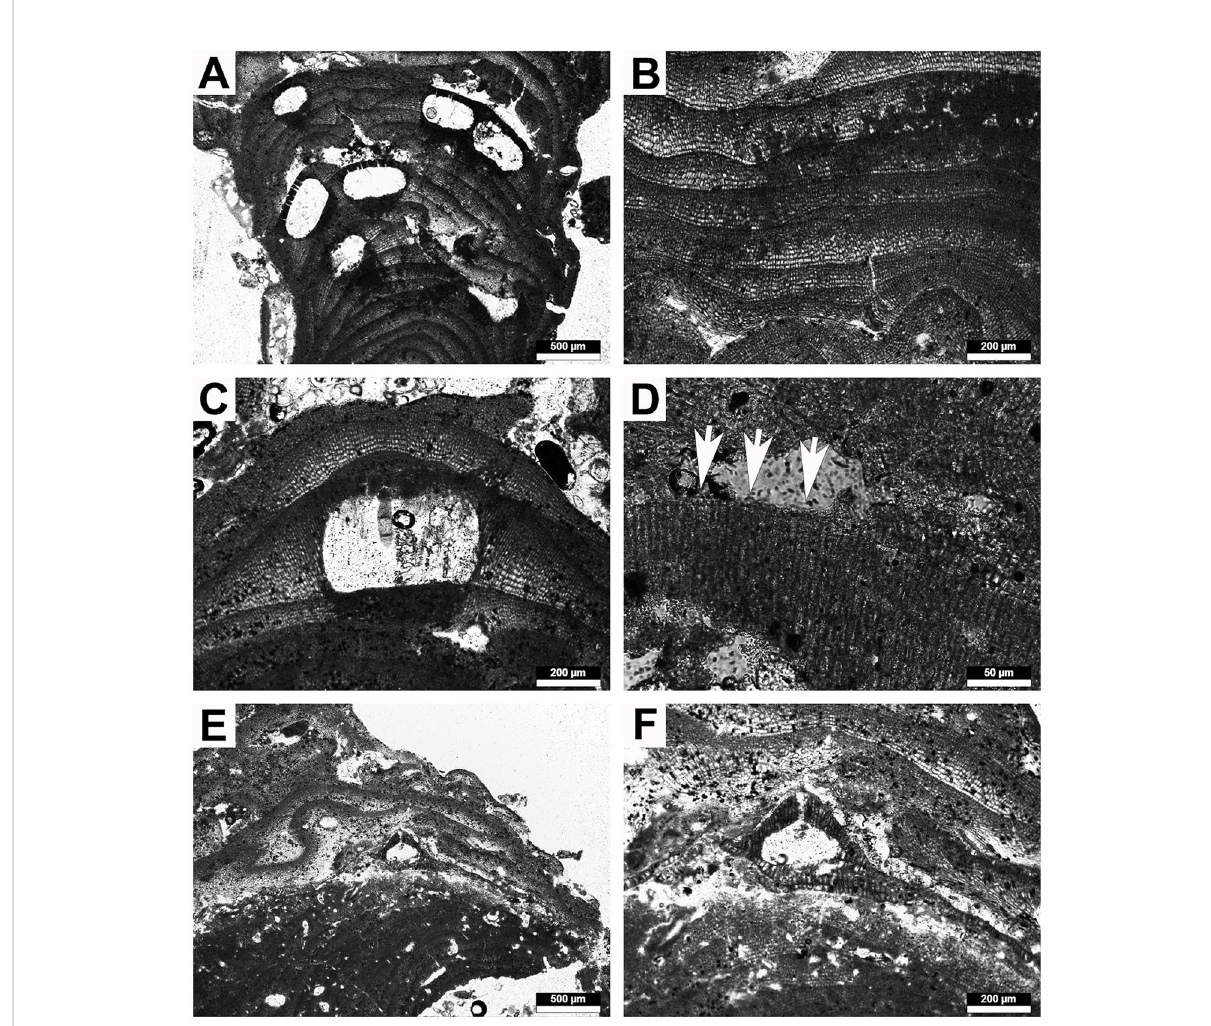
FIGURE 6 Representative rhodolith forming crustose coralline algae. (A – D) Lithothamnion cf. corallioides . (A) Portion of thallus with multiporate conceptacles, (B) detail of zoned peripheral region, (C) multiporate conceptacle with zoned tetraspore, (D) detail of epithallial cells (arrows). (E, F) Lithoporella sp. (E) Thallus of Lithoporella interspersed between other coralline thalli, (F) detail of uniporate